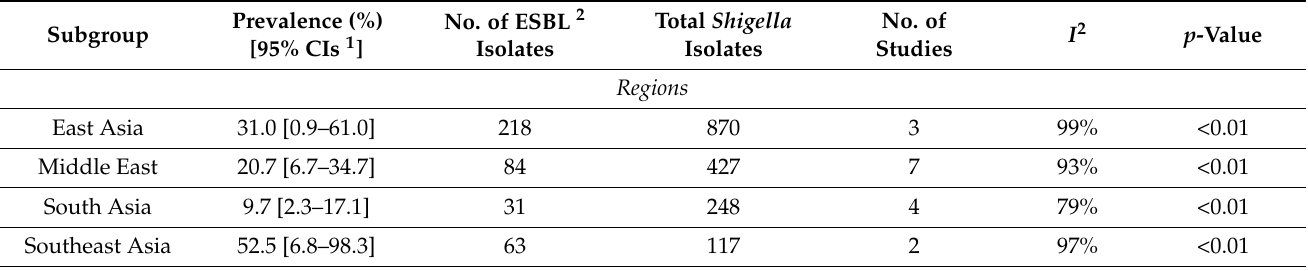
Table 5. Pooled prevalence of ESBL-producing Shigella spp. in different Asian